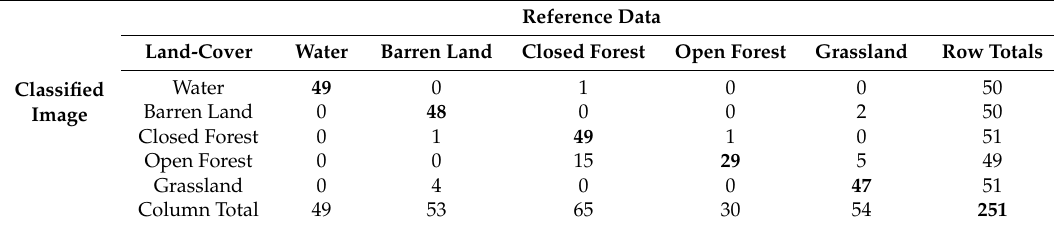
Table 6. Confusion matrix